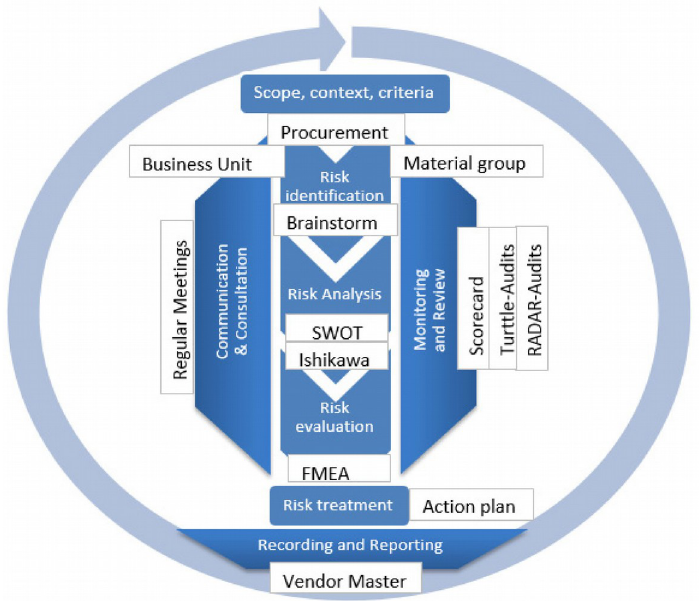
Figure 2. Risk management process (Adapted from ISO 31000,